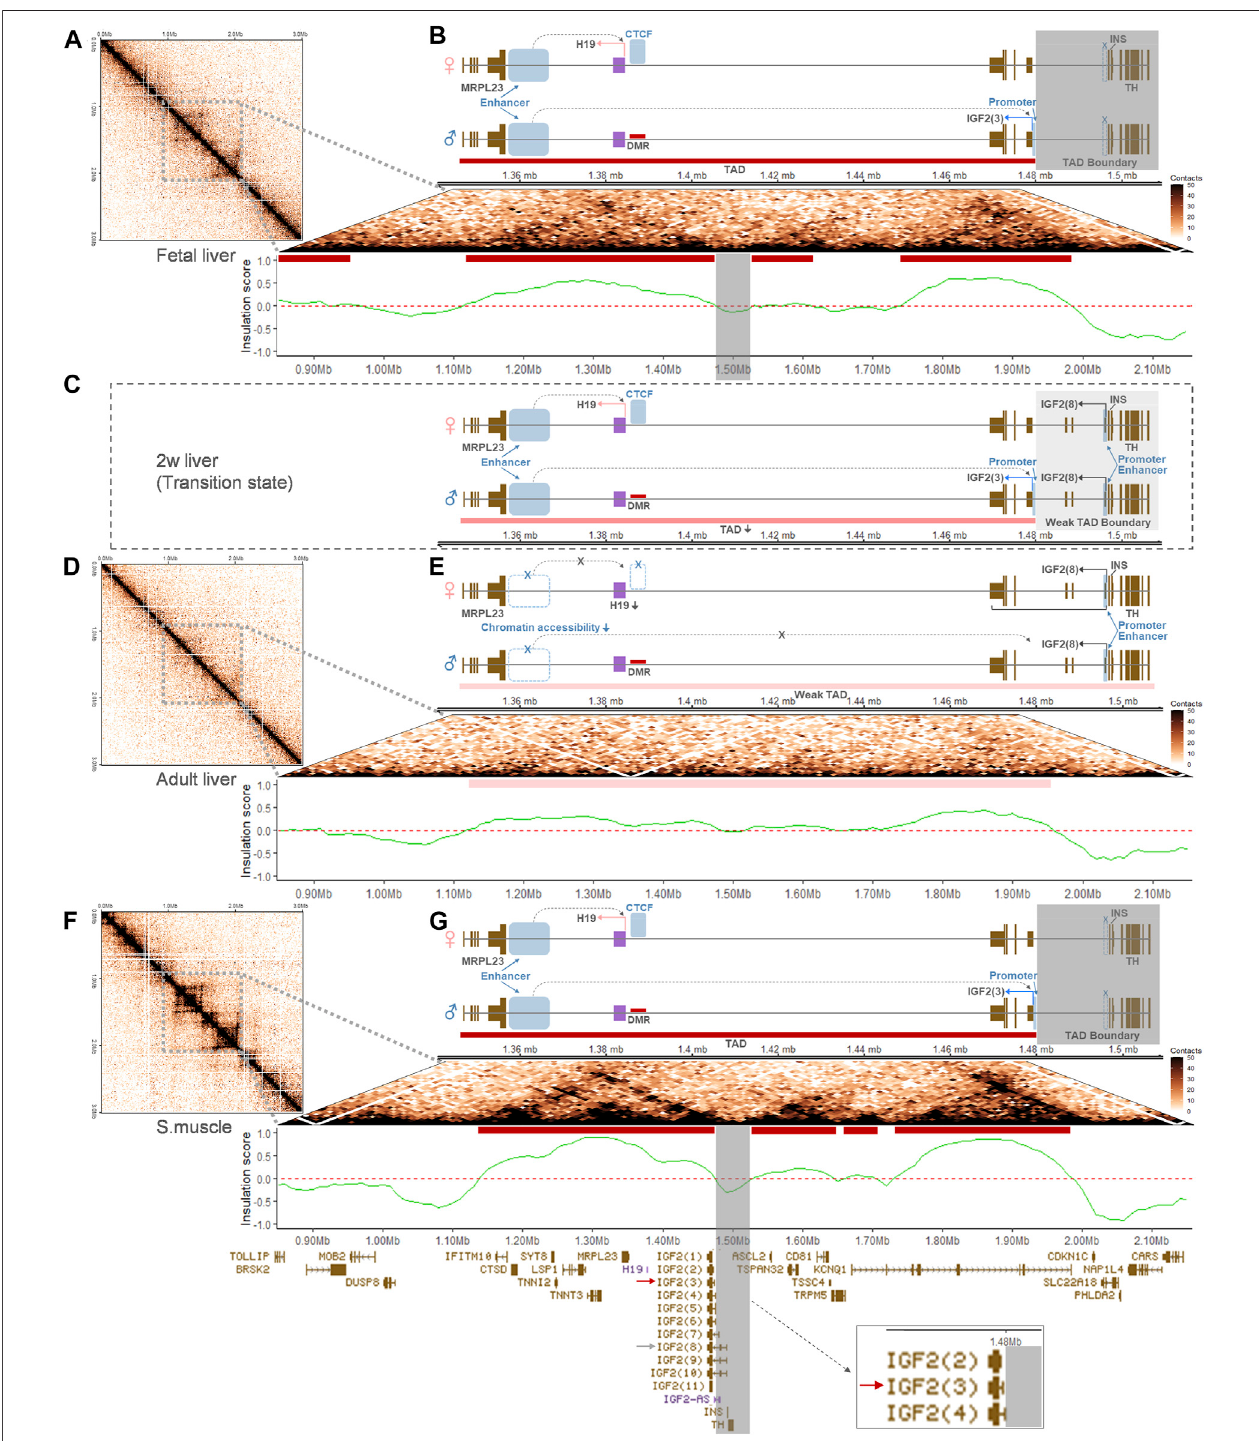
FIGURE 9 | Chromatin interactions and schematic models of gene regulation at the porcine H19/IGF2 locus. For the chromosomal region (chr2:0-3000000) containing the H19/IGF2 locus, two-dimensional heatmaps of Hi-C contact matrices were generated at a 10-kb resolution using the GENOVA R-package. Corresponding truncated pyramid plots zoomed in the locus. TADs were identi fi ed based on insulation scores and are indicated with red bars. (A,B) In the fetal liver, a TAD boundary is indicated with the grey perpendicular shades and a schematic diagram displays the long-range enhancer-promoter communication for paternal IGF2(3) expression within the TAD. Active regulatory elements are denoted with blue rectangles. In the maternal allele, CTCF binds to the hypomethylated region and expression of H19 is promoted by an active enhancer. (C) A proposed schematic model of less chromatin interaction and week TAD boundary is shown for a